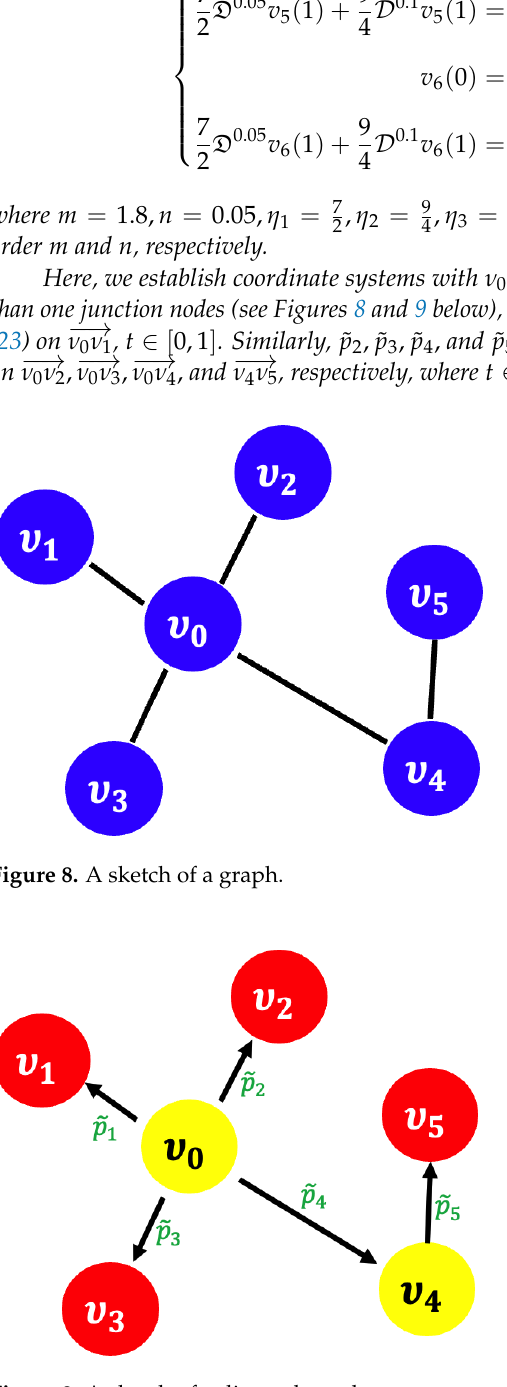
Figure 9. A sketch of a directed